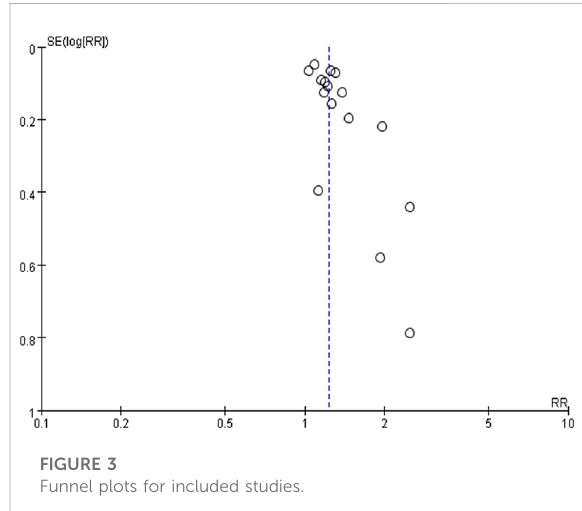
FIGURE 3 Funnel plots for included